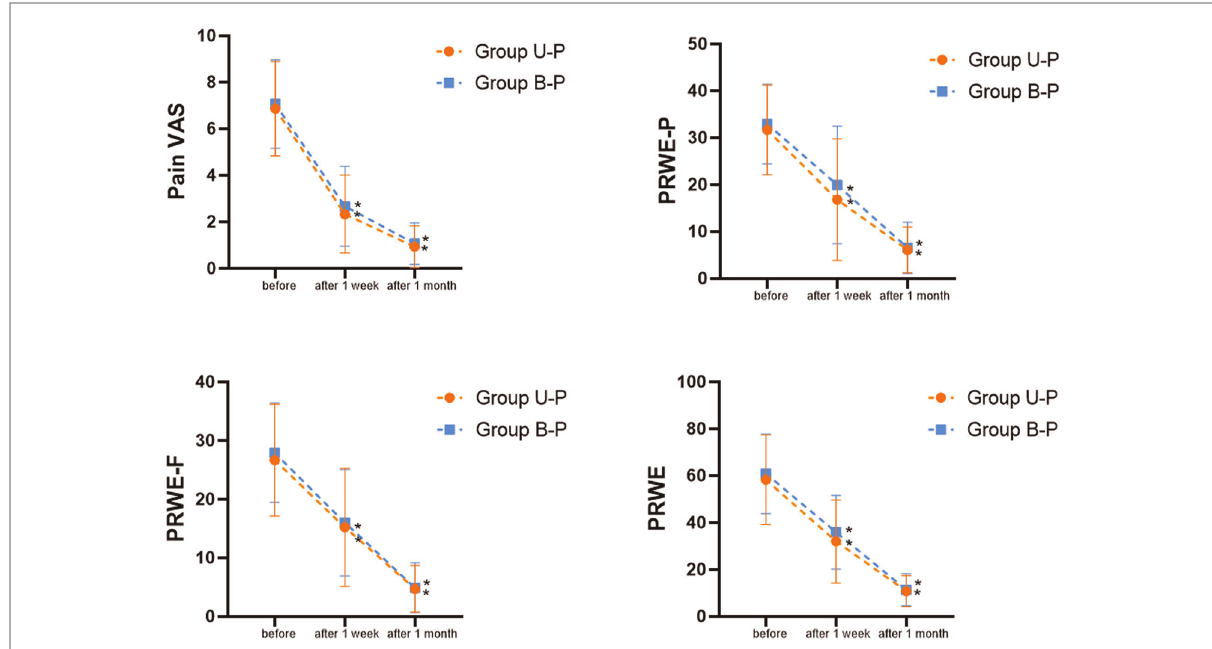
FIGURE 8 Comparison of the effects of ultrasound-guided acupotomy (group U-P) and blind acupotomy therapy (group B-P) in dQD patients. * compare to before ( P